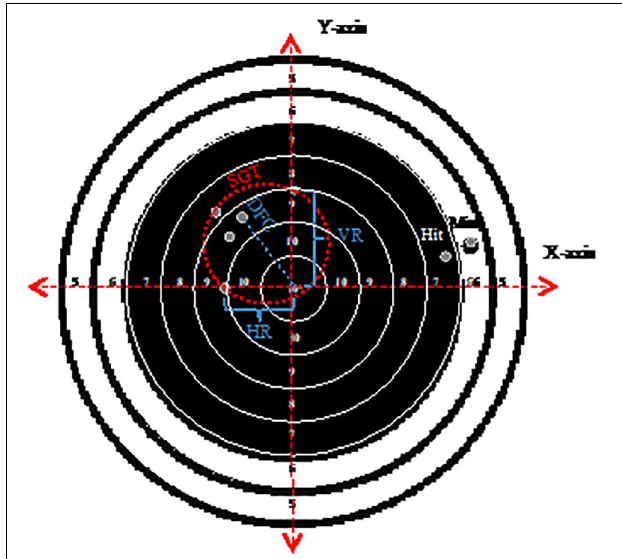
FIGURE 1 | Illustrational overview over dispersion measures. Horizontal range (HR), vertical range (VR) and shot-group tightness (SGT) represents the correct values for the example shown. For distance from center (DFC) the example is only shown for one shot. The average for all five shots would be representative. Shots marked as Hit and Miss are added for extra illustrations. The circles from 4 to 0 points are not shown in the